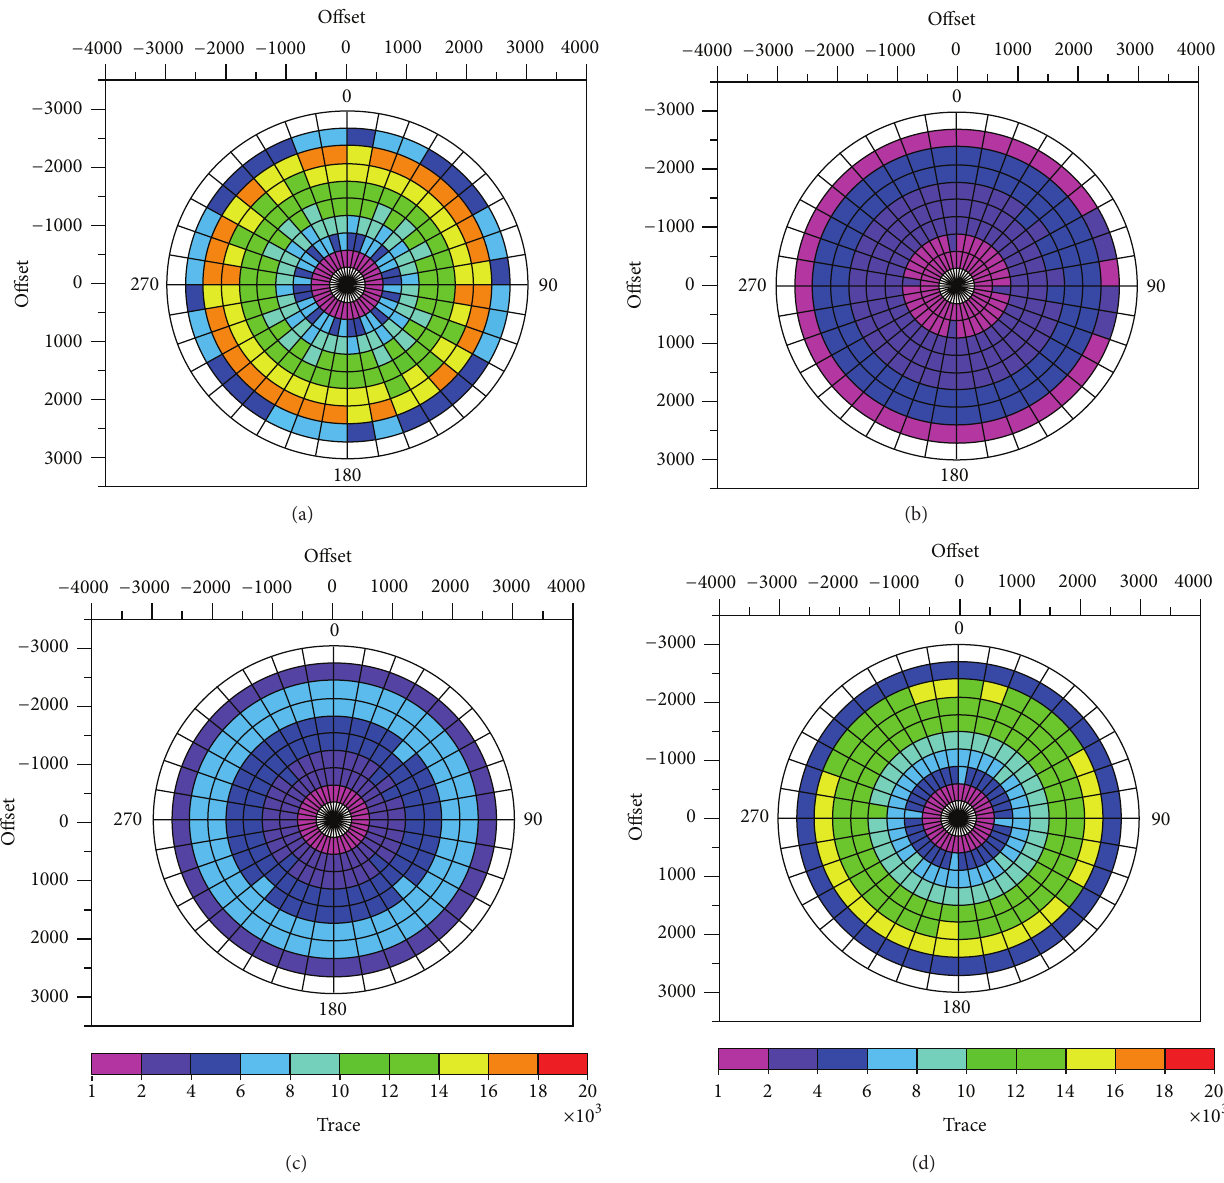
Figure 5: Total ray coverage in (a) acquisition with no cultural noise, (b) acquisition with real cultural noise, (c) traditional recovery method applied on (b), and (d) new recovery strategies applied on